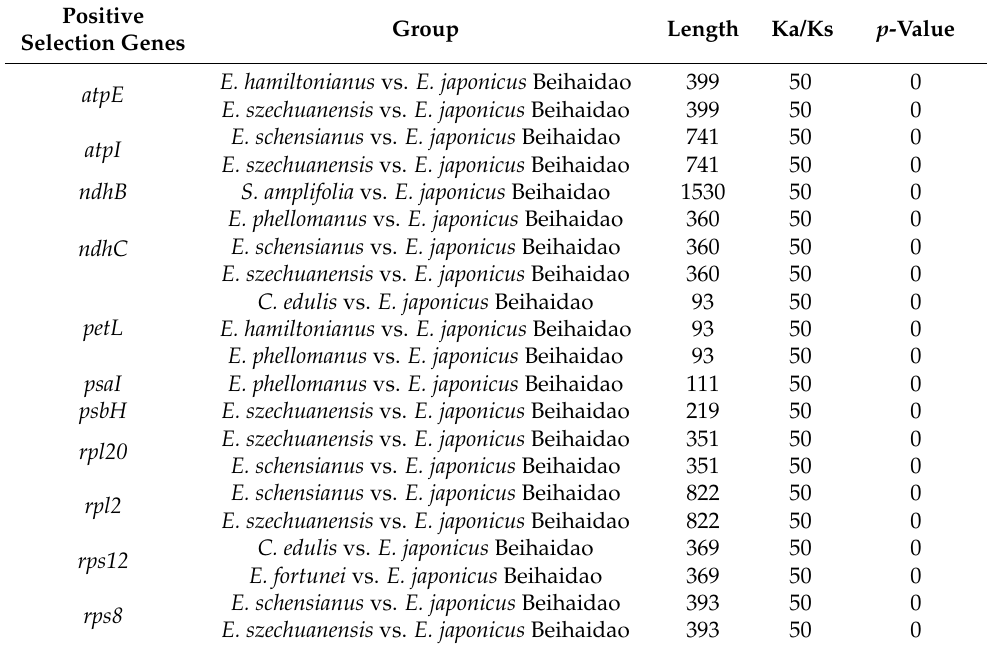
Table 7. Eleven positive selection genes in Celastraceae